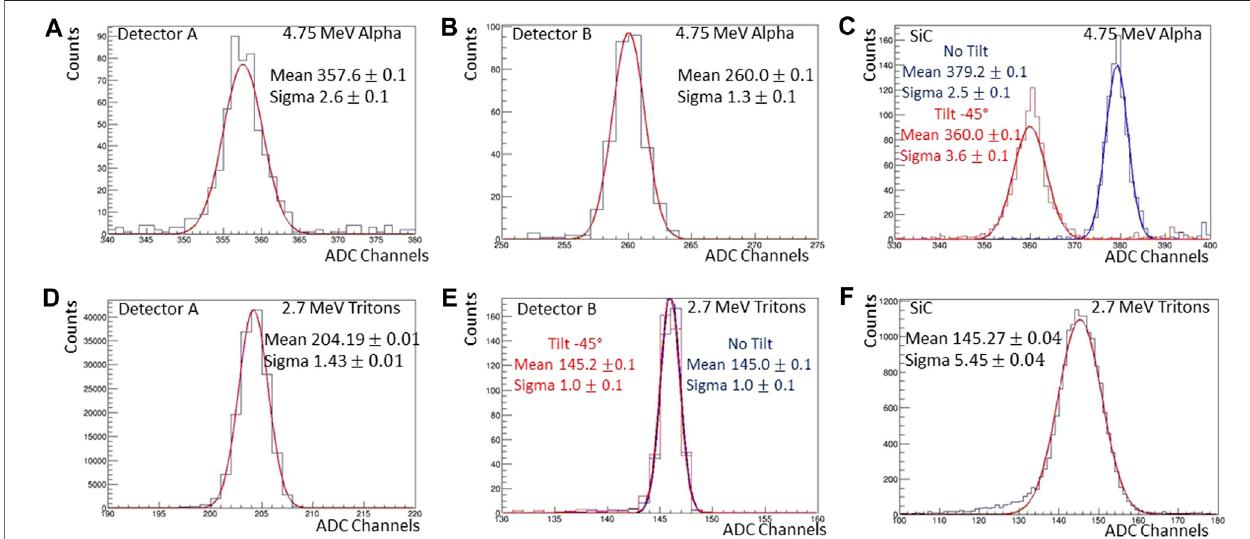
FIGURE 7 | Energy resolution with 4.75 MeV α particles of diamond detectors A (A) , B (B) at normal incidence and for SiC both at normal incidence and with a detectortiltof-45 ° (C) .Energyresolutionwith2.7 MeVtritonsatnormalincidenceforbothdiamonddetectorA (D) andSiC (F) andcomparedresultsatnormalincidence and with a detector tilt of -45 ° for diamond detector B (E)